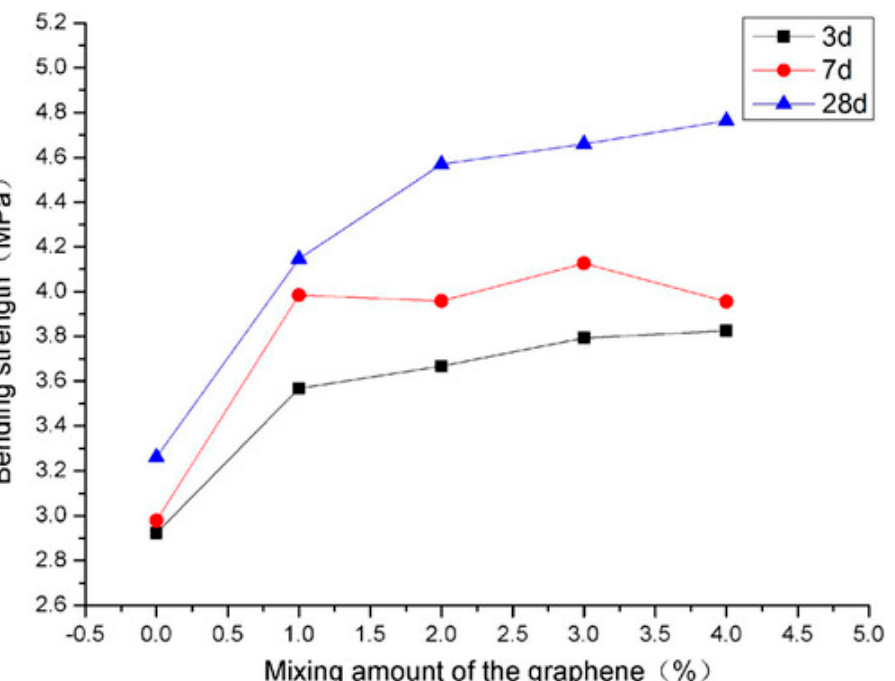
Figure 40. Effect of graphene amount on bending strength [235]. Figure 40. E ff ect of graphene amount on bending strength